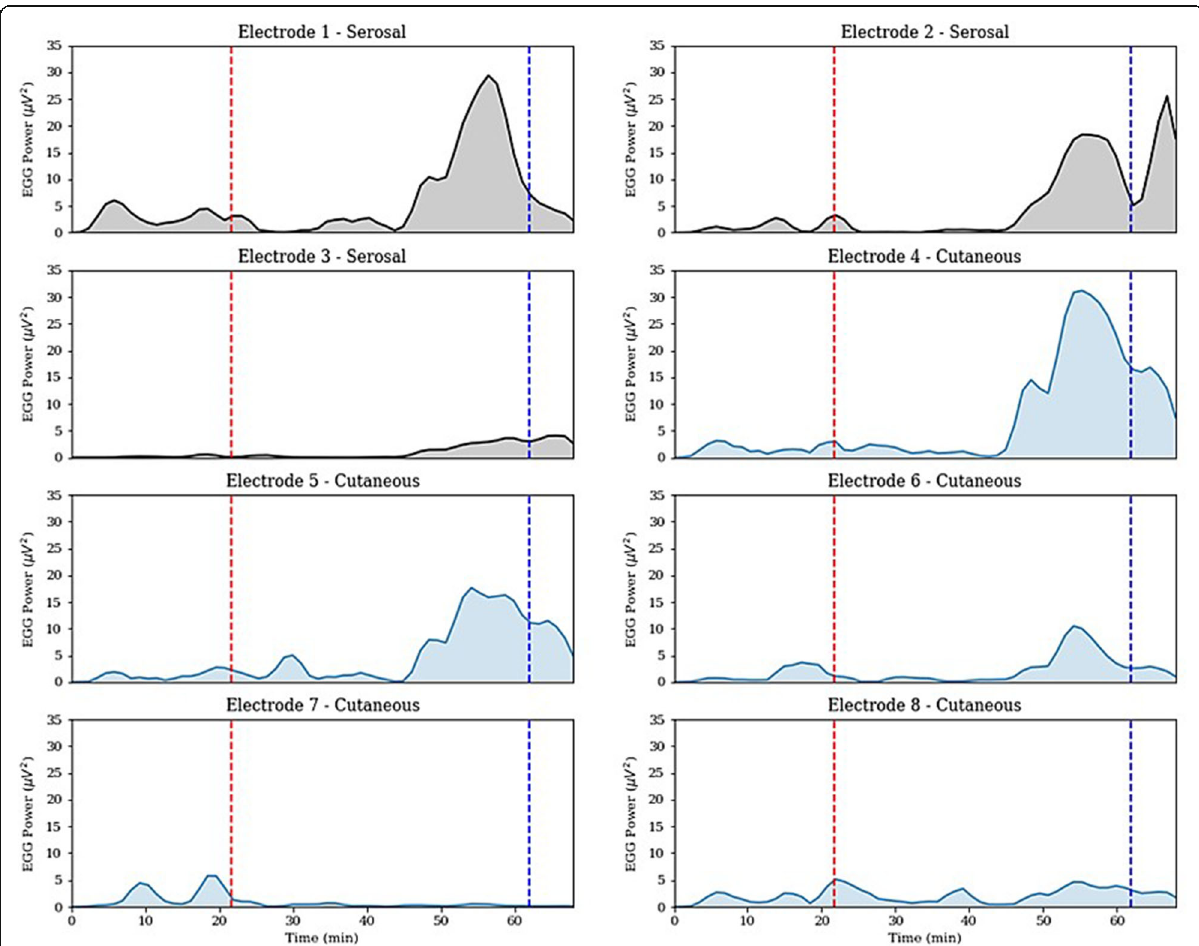
Fig. 6 EGG Average Power. The average power in six of the eight electrodes was shown to increase during the same theorized entrainment period. A buffer period is also present in this analysis, where pacing has started but motor activity has not yet unified. Red dotted vertical line represents the start of pacing and blue dotted vertical line represents the end of pacing. Grey plots represent serosal electrode measurements, blue plots represent cutaneous electrode